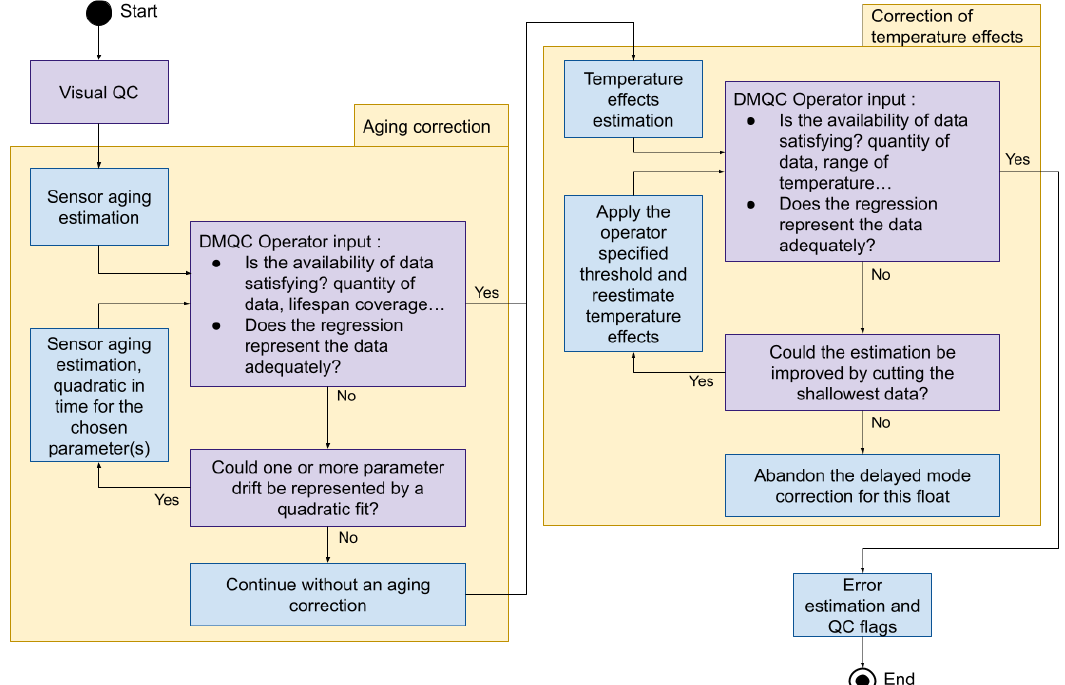
Figure 3. Flowchart of the QC procedure to correct radiometry for aging and temperature dependency.